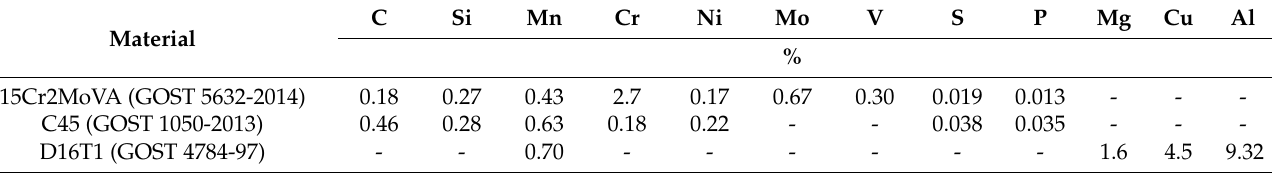
Table 1. Chemical composition of the materials.